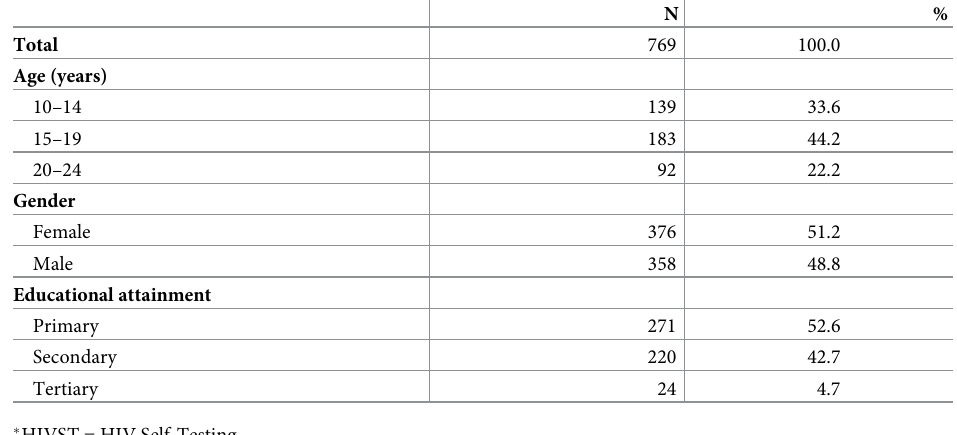
Table 1. Key characteristics of contest entries, HIVST � crowdsourcing contest participants—Nigeria, 2018 (n = 769 eligible